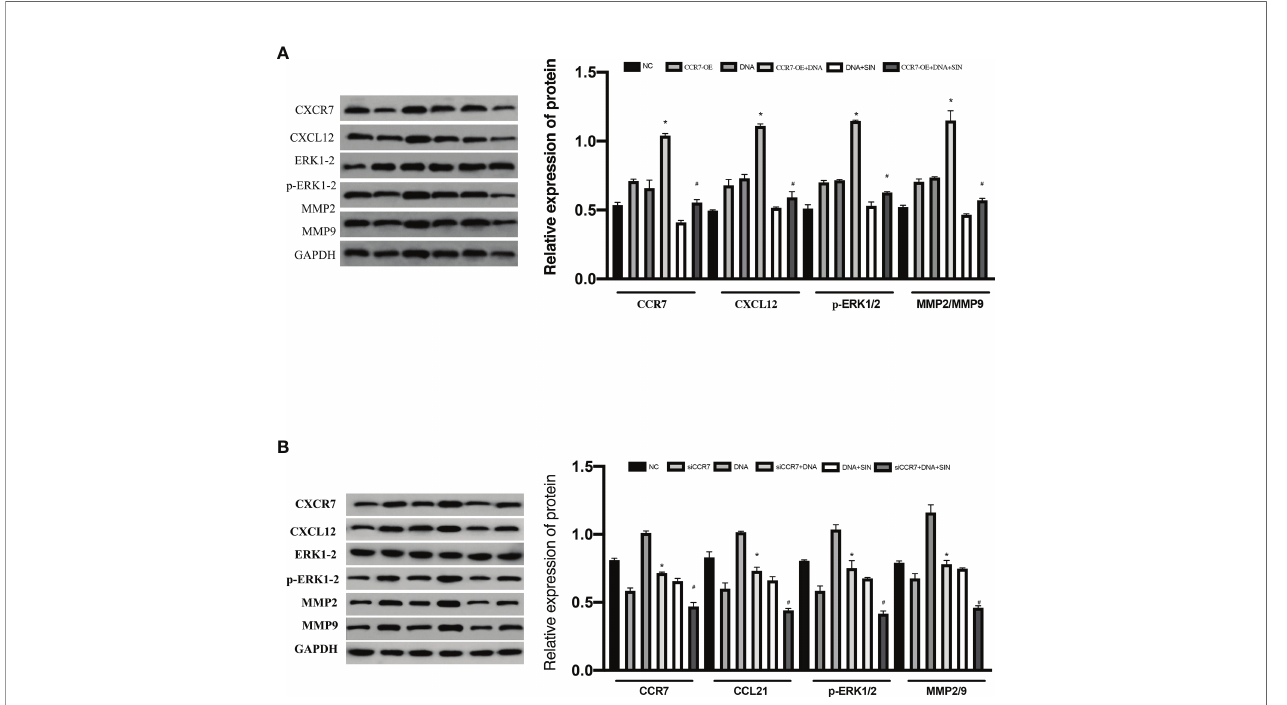
FIGURE 7 | Interfering with tumor-derived DNA by sinomenine hydrochloride affects the ERK/MMP signaling pathway through the CCL21-CCR7 axis in HCC cells. (A) The expression of p-ERK1/2, MMP2, and MMP9 proteins in SK-Hep1 cells after siCCR7 transfection. (B) The expression of p-ERK1/2, MMP2, and MMP9 proteins in SK-Hep1 cells after CCR7-OE transfection. *P < 0.05(compared with NC), # P<0.05(compared with DNA+SIN